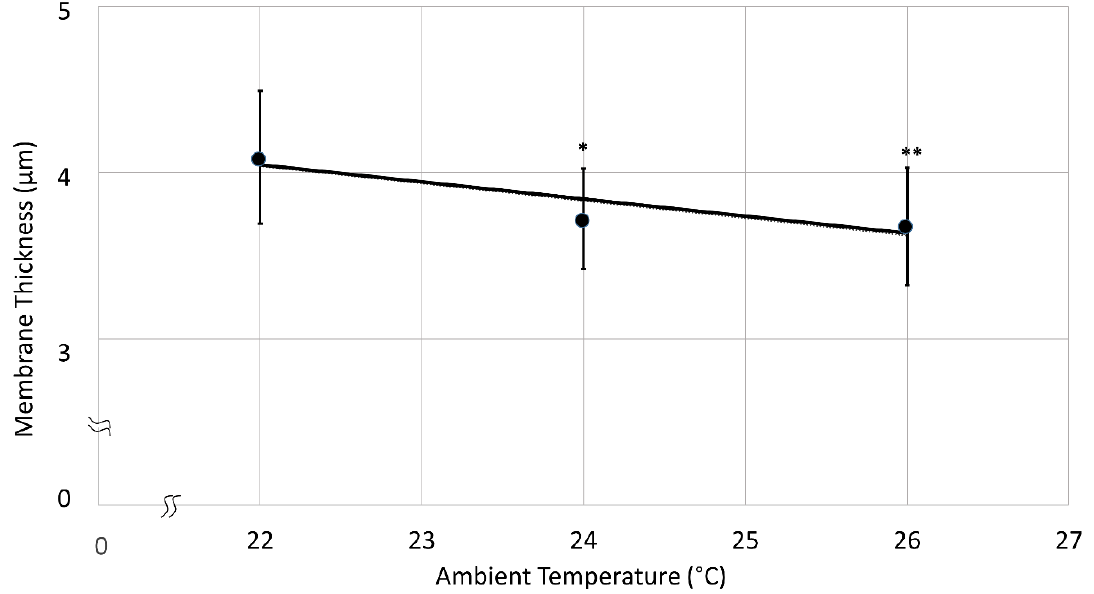
Table 3. Measured thickness values of membranes produced in different room temperatures.